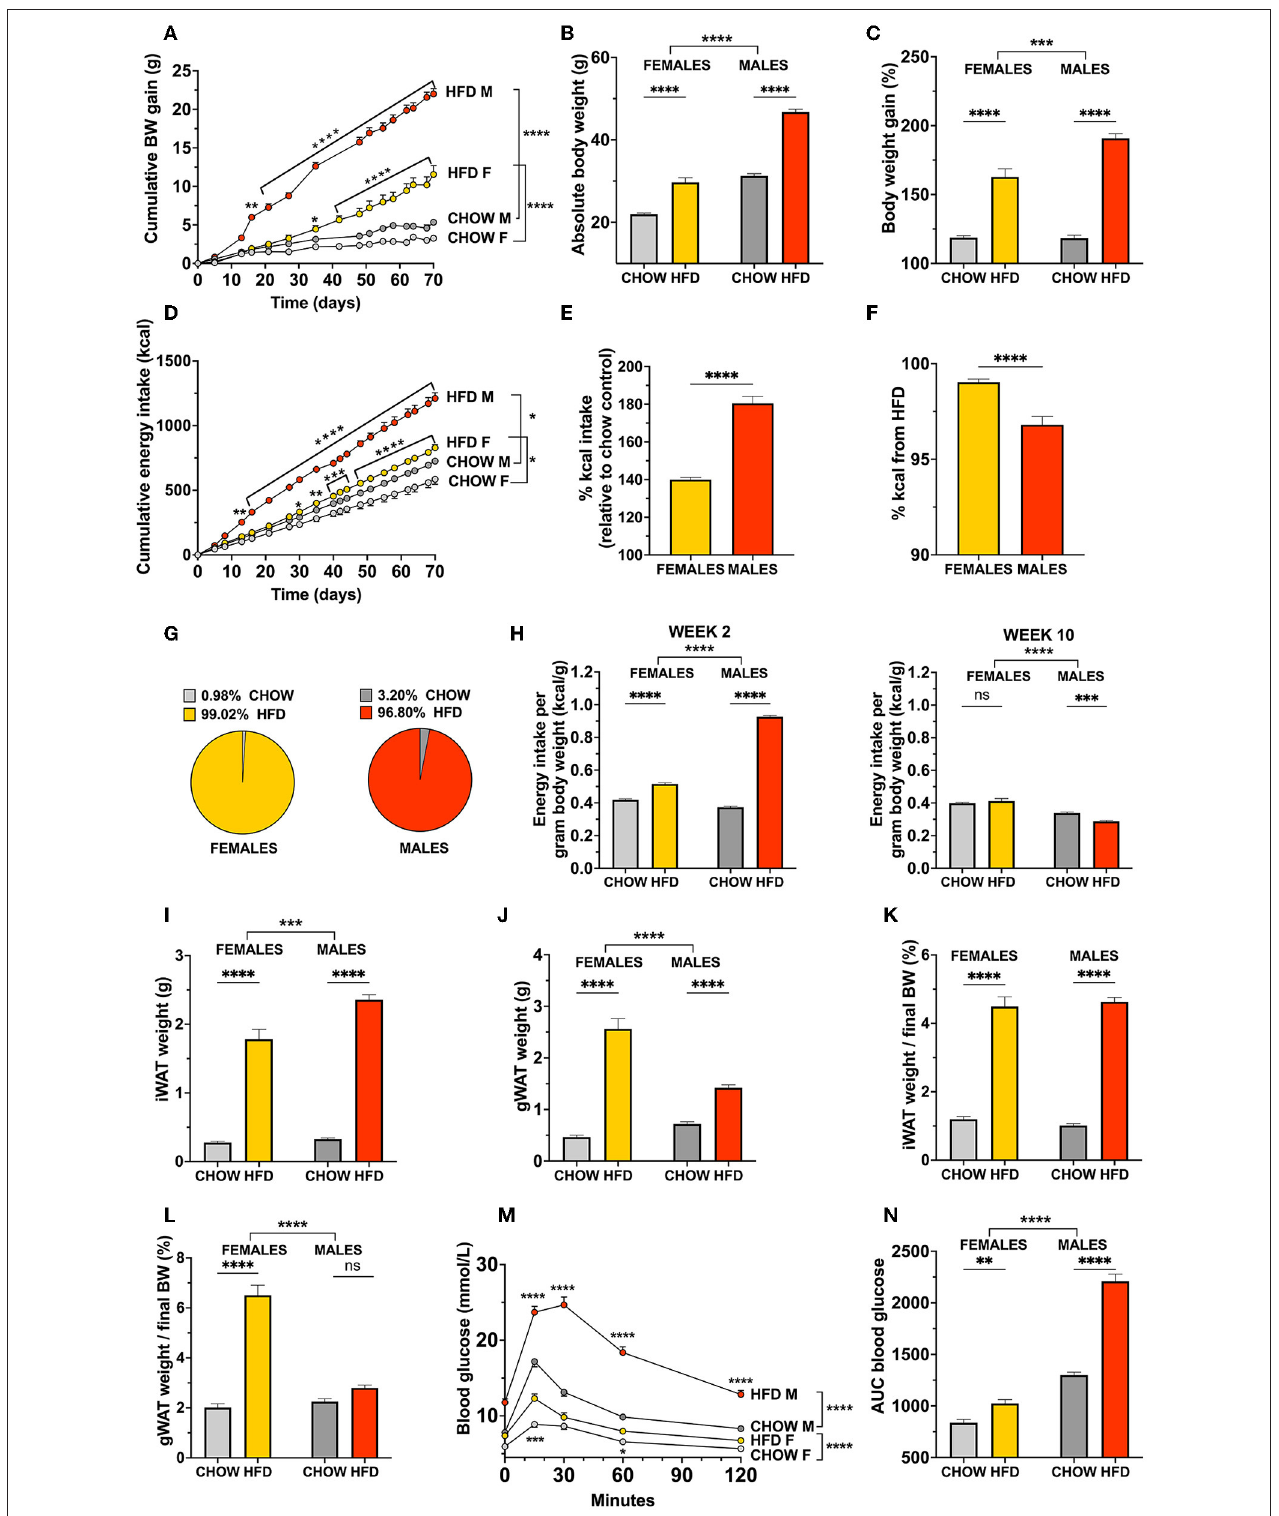
FIGURE 3 | Sex divergent effect of a high-fat choice diet challenge in mice. When offered a high-fat and chow choice diet, mice responded with a pronounced hyperphagia (D) and weight gain (A) that had a more rapid onset in males compared to females. In contrast to rats, both female and male mice presented a dramatic increase in body weight gain (B,C) , overeating (E) , adiposity (I–L) . Female mice gained 3-fold more visceral fat compared to males (L) . Both sexes showed impaired